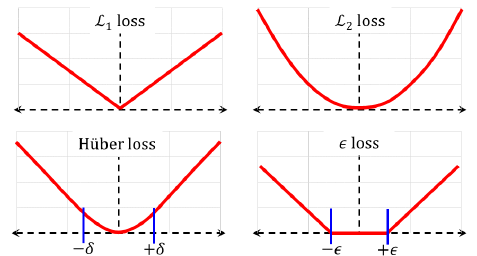
Figure 1. Loss Functions. Losses L as functions of the difference between the model output y , and the corresponding target (desired output) t